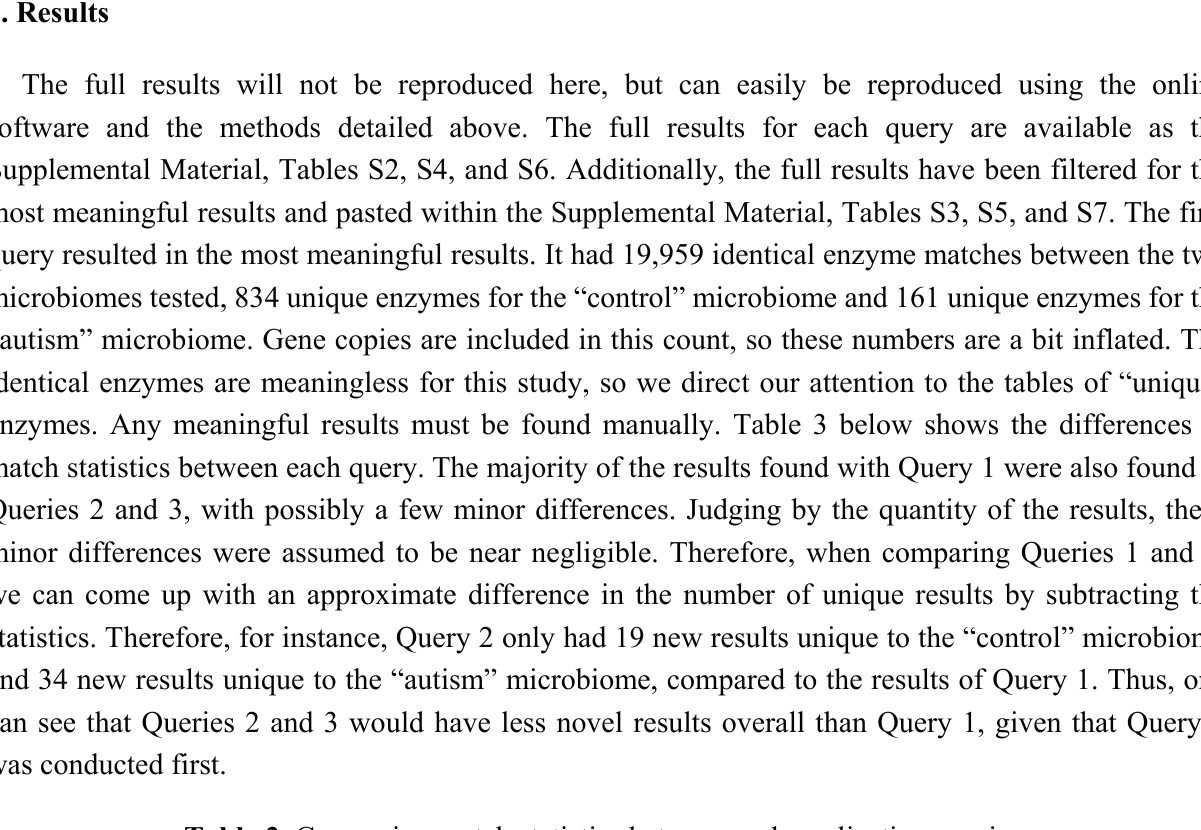
Table 3. Comparing match statistics between web application